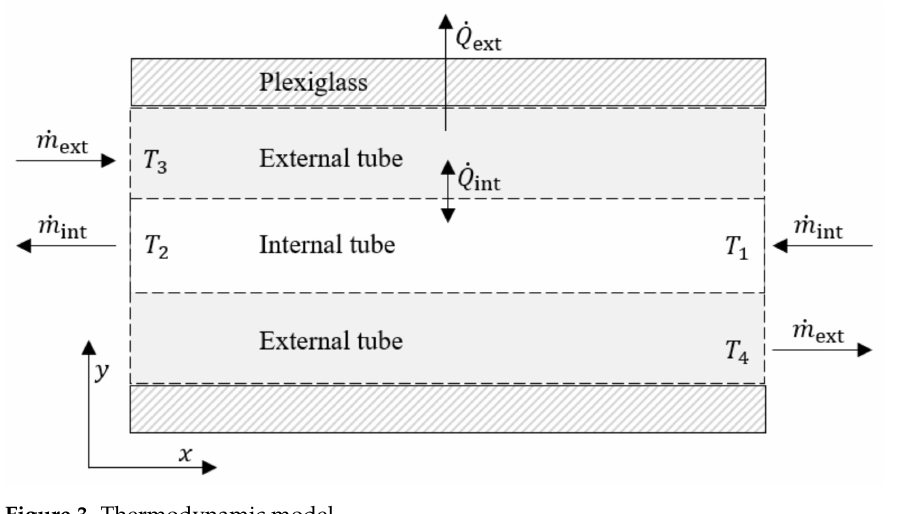
Figure 3. Thermodynamic